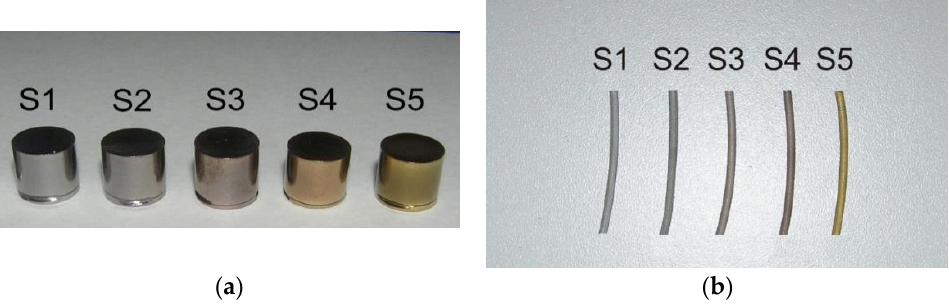
Figure 1. Test samples: ( a ) microscopic and chemical composition tests; ( b ) ion release tests. Table 1. Chemical composition of tested alloy. Element Percentage wt.%